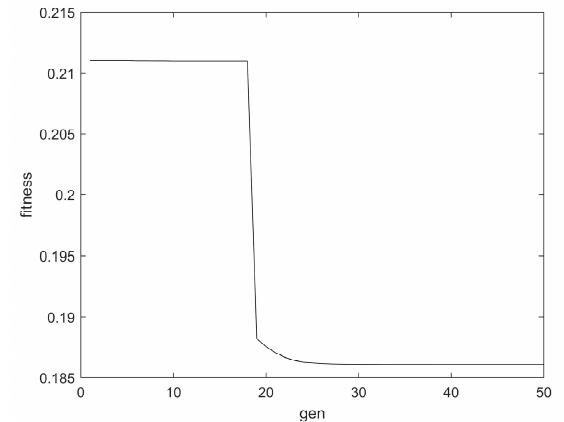
Figure 7. The fitness in the optimization process. After the VMD, K IMF components can be obtained, and the instantaneous frequency and instantaneous amplitude of IMF components can be obtained by applying the Hilbert transform on the IMF components. For the time signal x(t) , its Hilbert transform expres- sion [23] is The time-domain diagram and the time-frequency diagram of the ground current signal after the VMD are shown in Figure 8. The time-domain diagram shows that each IMF obtained after the VMD is a sinusoidal wave, and the time-frequency diagram further illustrates that these IMFs are actually fundamental and odd harmonics, so that the ground current is composed of a fundamental and a series of odd harmonics. As aging proceeds, the amplitude of each odd harmonic increases compared to the unaged sample, which can indicate that there is a certain connection between aging and harmonic gener- ation.